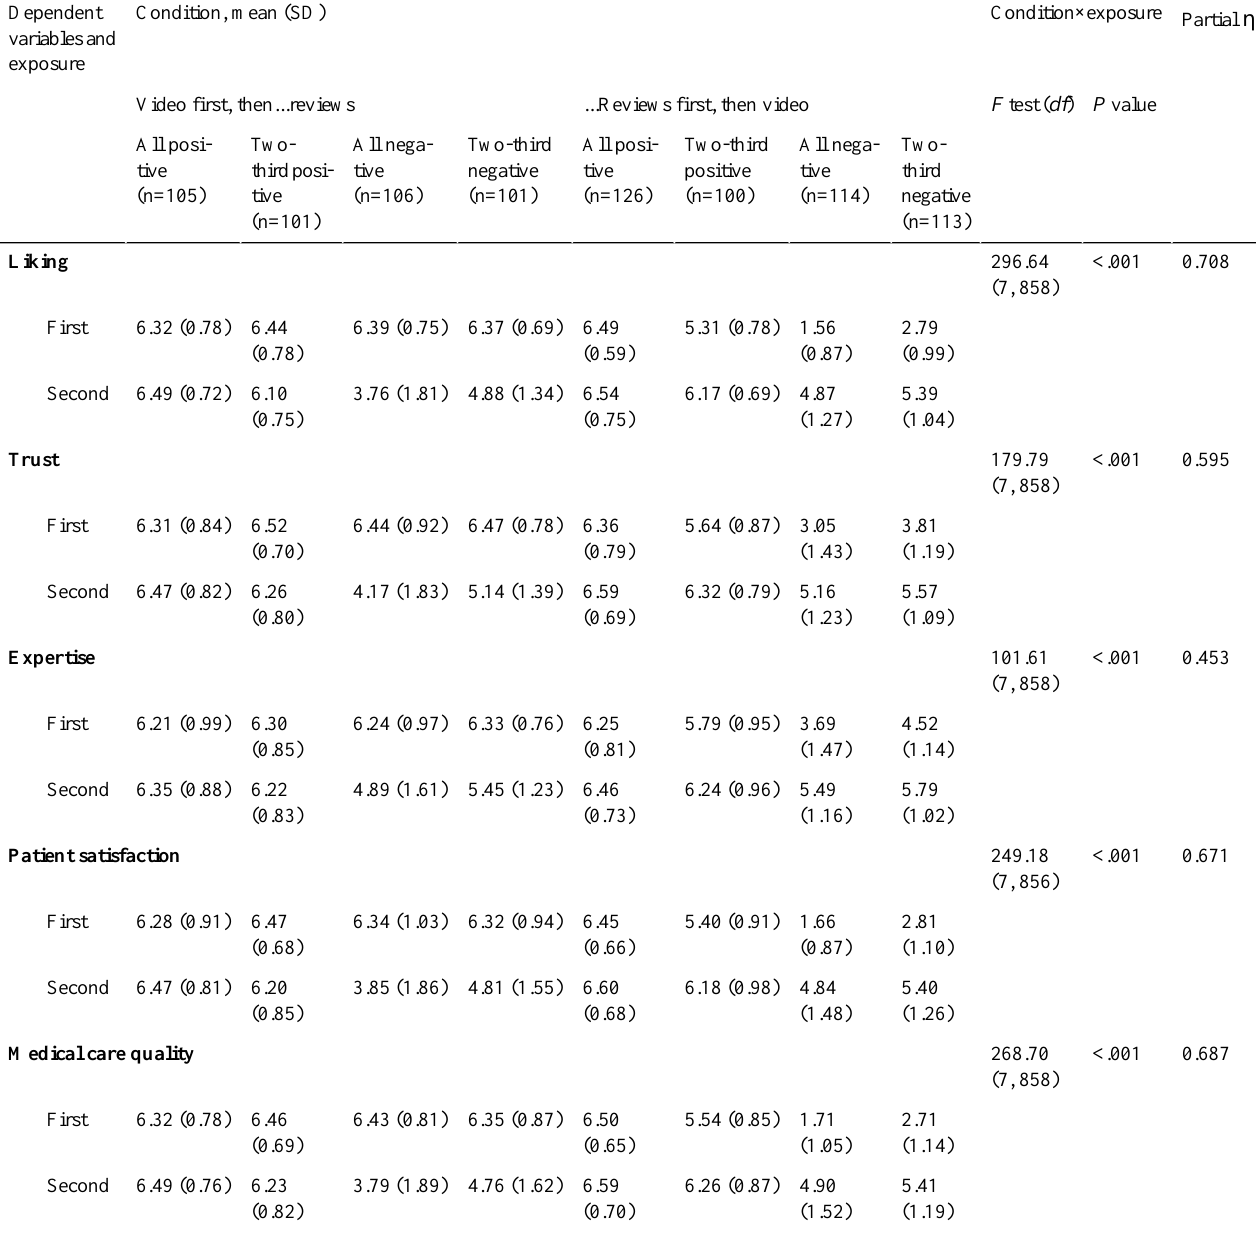
Table 2. Descriptive statistics and mixed analysis of variance